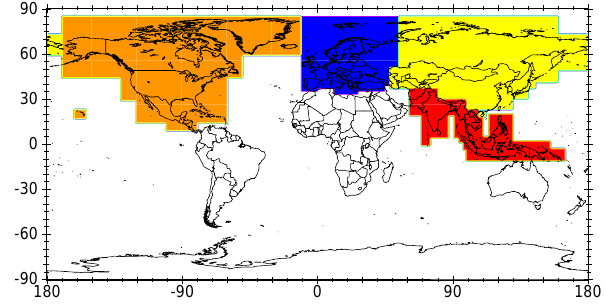
Fig. 1. Depiction of the regions used for the computation of the emissions summaries in Tables 2 and 3. Red: Southern Asia; yel- low: Northern Asia; blue: Europe; Orange: North America.